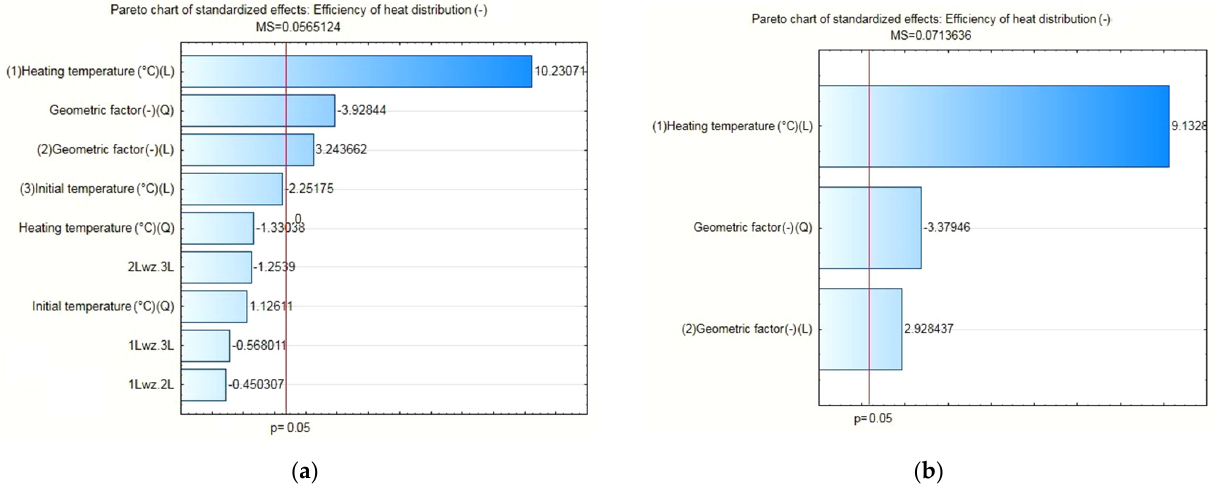
Figure 10. ( a ) Pareto chart for all input quantities of interest and their correlation to the output quantity value; ( b ) Pareto chart for the statistically significant input quantities, applicable to the pure PCM heat accumulator.